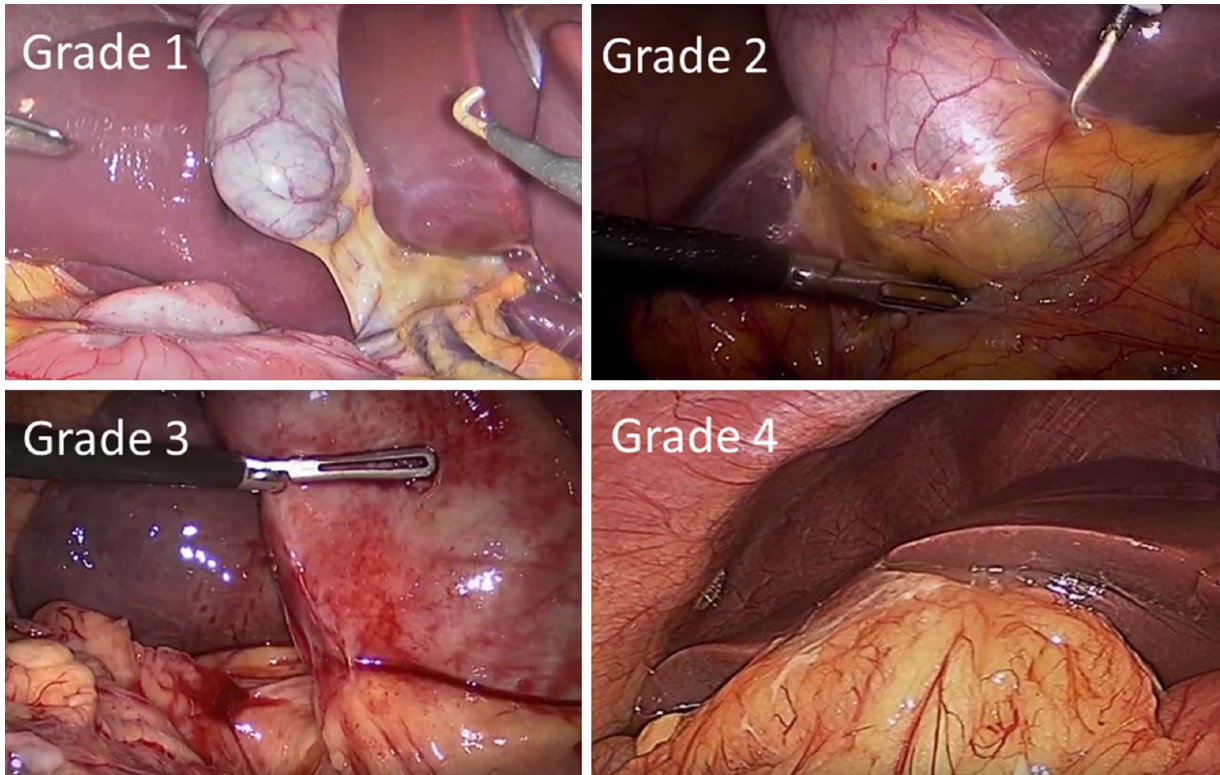
Figure 2. Intra-operative laparoscopic images of the Nassar operative difficulty grades.